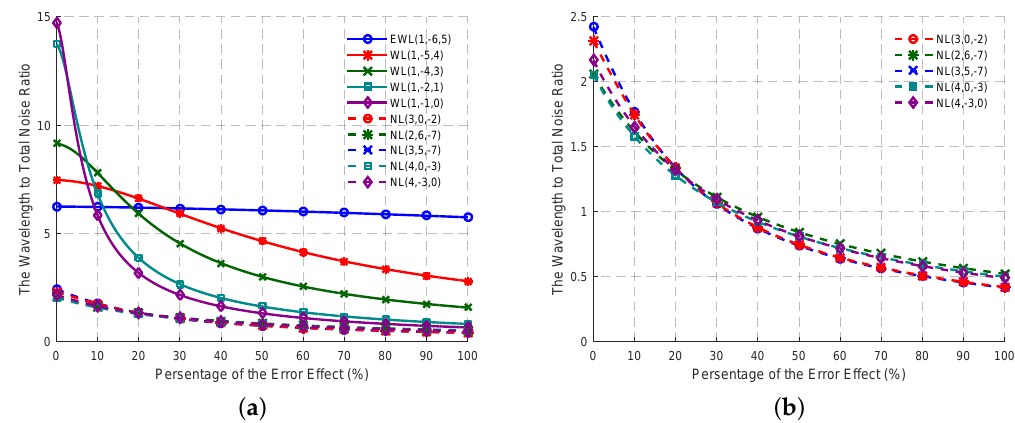
Figure 7. The variation trend of the wavelength to total noise ratio of the selected combined signals in Table 5 updates with the effect percentage of the total noise level from 0 to 100. ( a ) The EWL, WL and NL combined signals; ( b ) The NL combined signals